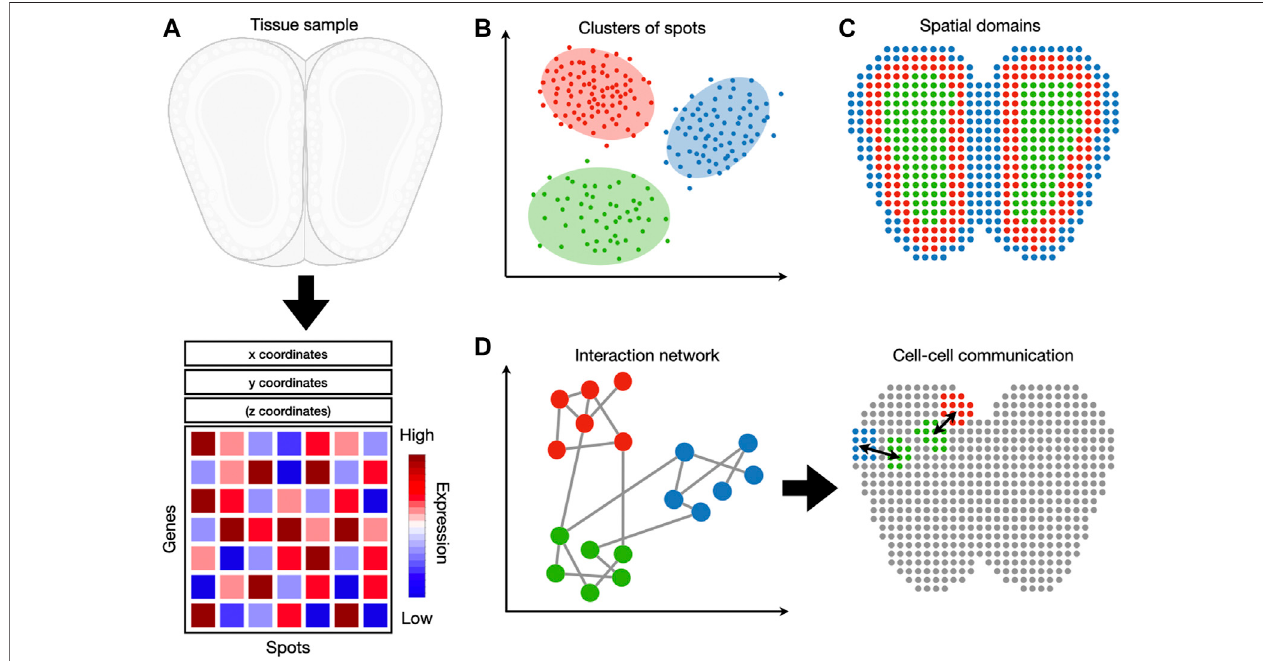
FIGURE1| Anoverviewofspatialtranscriptomictasks. (A) Spatialtranscriptomicdatasetsmapgeneexpressionmeasurementstotheirrespectivelocations. (B) A spatialtranscriptomicdatasetcanbeanalyzedingeneexpressionspace,irrespectiveofspatiallocations.Taskssuchasclusteringandcell-typeidenti fi cationfallintothis category. (C) Spatial information can be used jointly with gene expression to detect spatial expression patterns and spatial domains. (D) These two sources of information can also be used to detect cell-cell and gene-gene